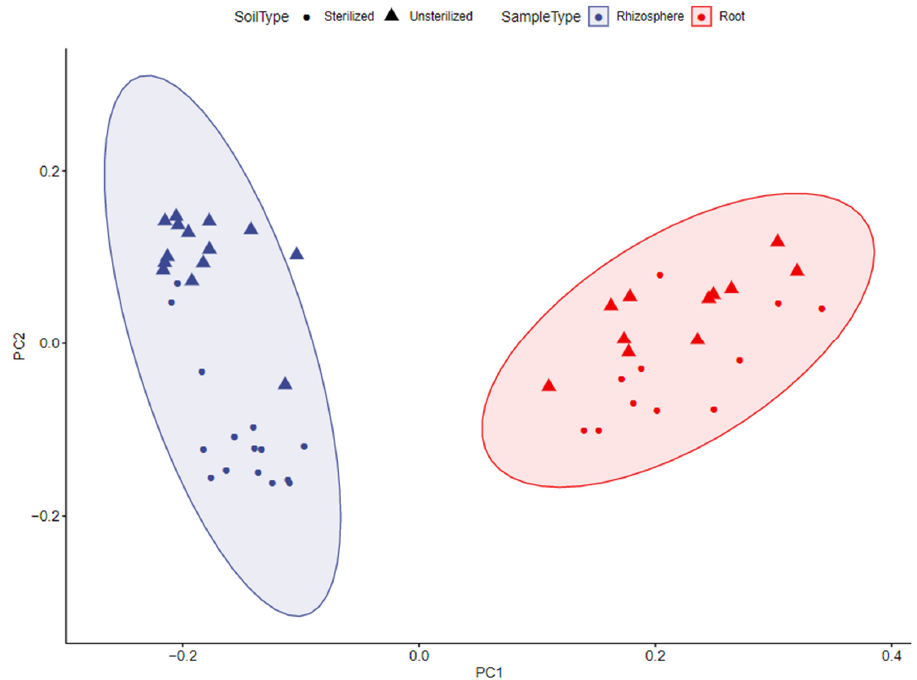
Figure 2. Principal coordinates analysis plot based on the weighted Unifrac distance metric for bacterial taxa. Ellipses represent standard deviations of the weighted average of treatments at the 95% confidence level. The rhizosphere soil is represented in blue, while the roots are represented in red. Eleven phyla dominated all root and rhizospere samples, with Acidobacteria, Actino ‐